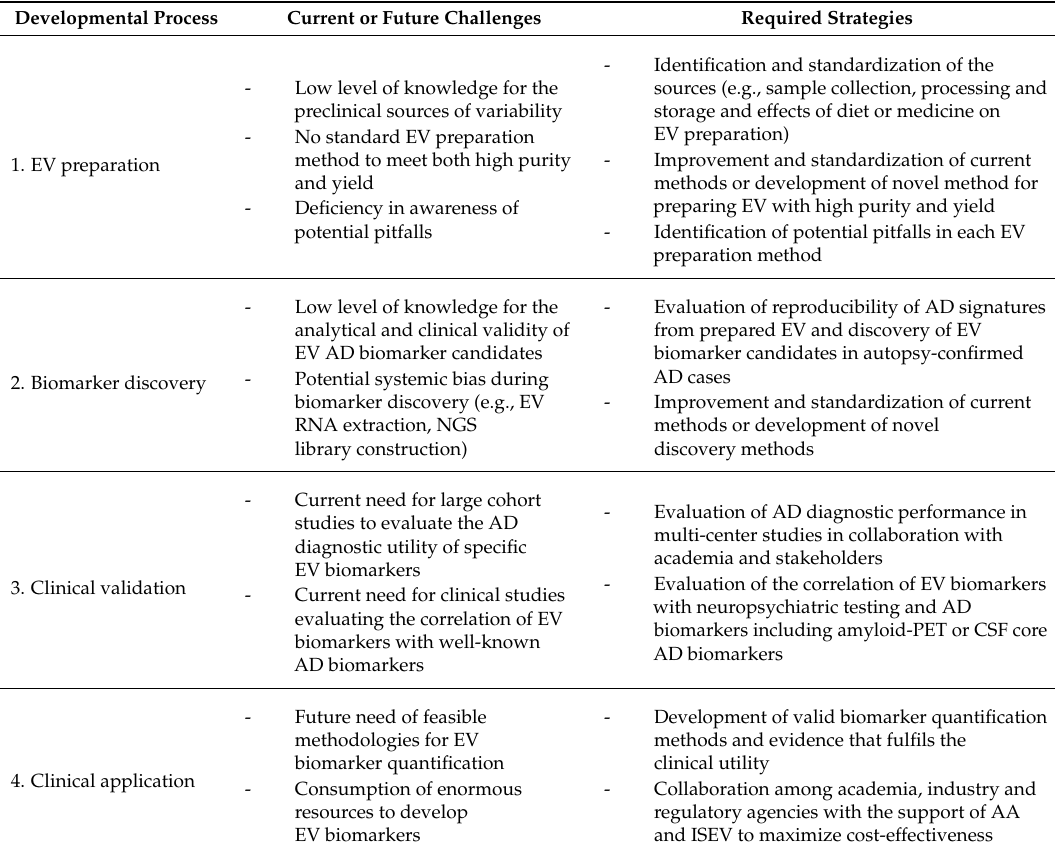
Table 2. Current challenges against the development of EV AD biomarkers and strategies to overcome the